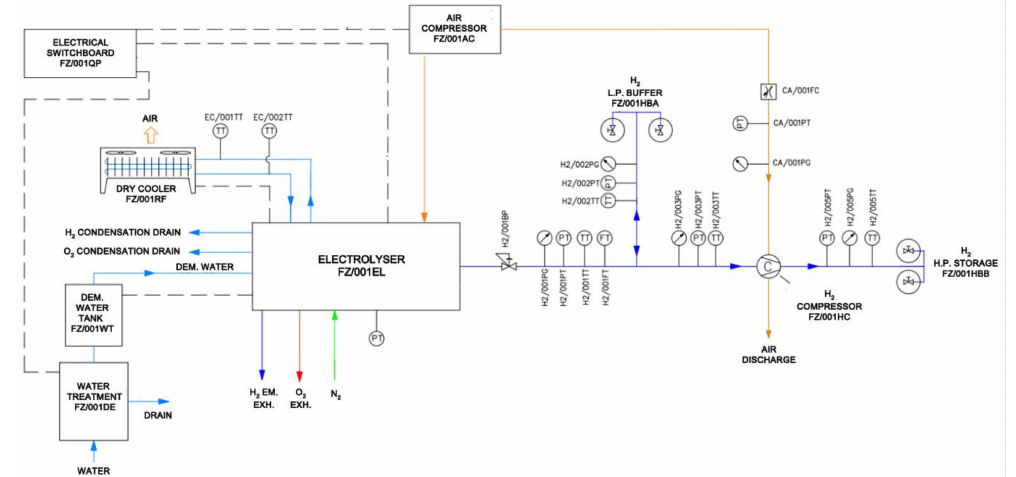
Figure 2. Piping and Instrumentation Diagram (P&ID) of the testing